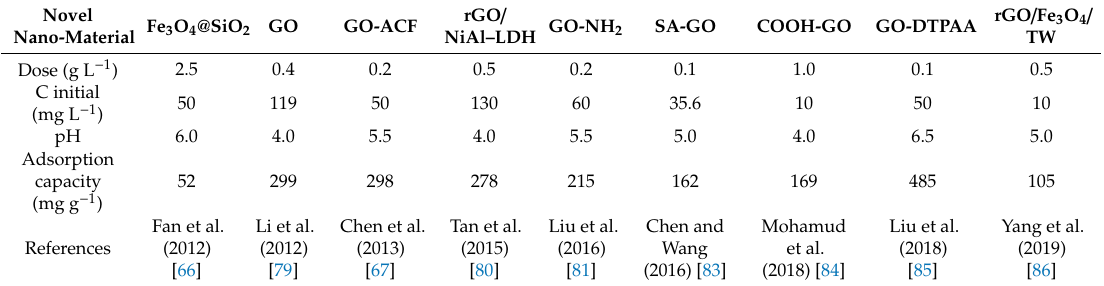
Table 5. Novel nanostructured materials applied for the removal of U(VI) from waste / water sources. Novel Fe 3 O 4 @SiO 2 GO Nano-Material